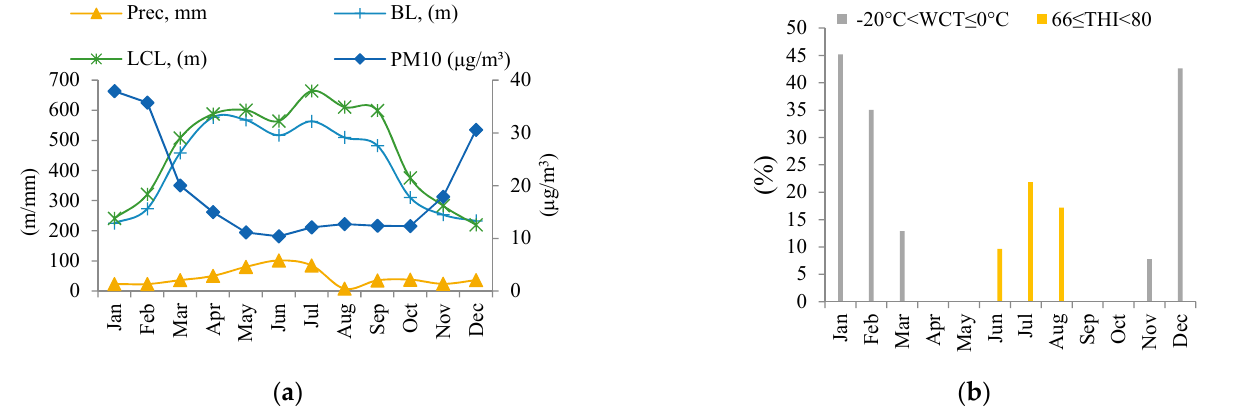
Figure 5. Annual and seasonal PM 10 categories evolution during the studied period (( a )—total days, ( b )—winter days, ( c )—spring days, ( d )—summer days, ( e )—autumn days).